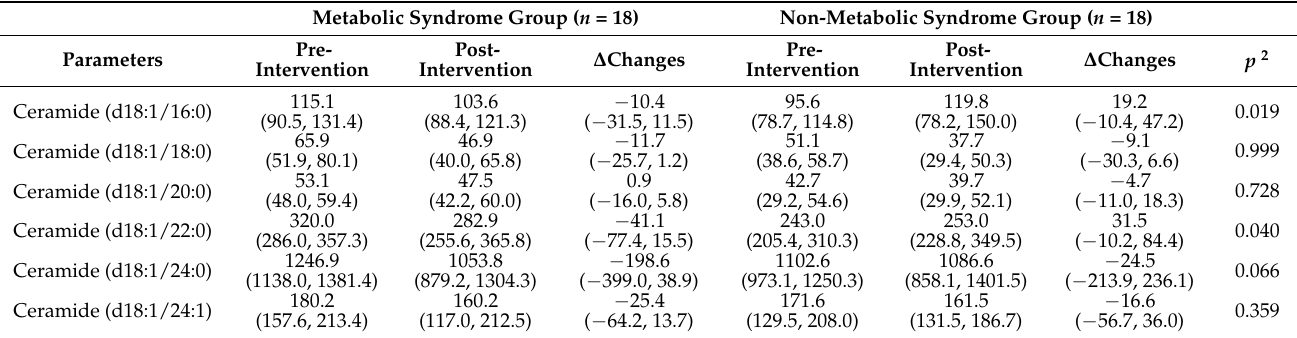
Table 4. Comparison of changes in serum ceramide levels before and after the 4-week intervention in subjects from the KRG group ( n = 36) with and without metabolic syndrome 1 .